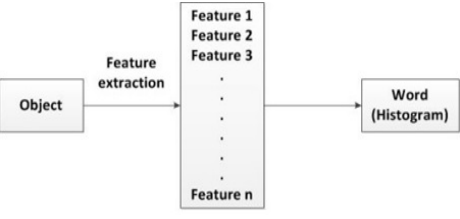
Figure 6. The process about creating a ‘word’ for one sample image in the train